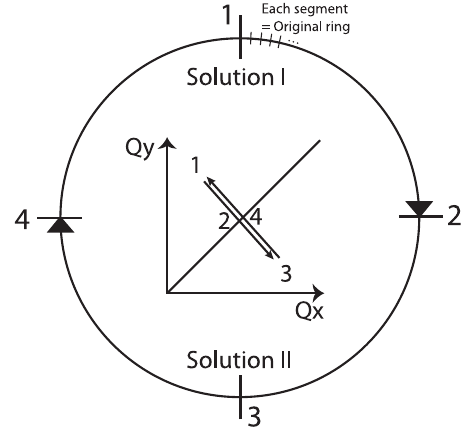
FIG. 1. “ Large ring ” that consists of many original rings. The working point of the original ring is also shown.